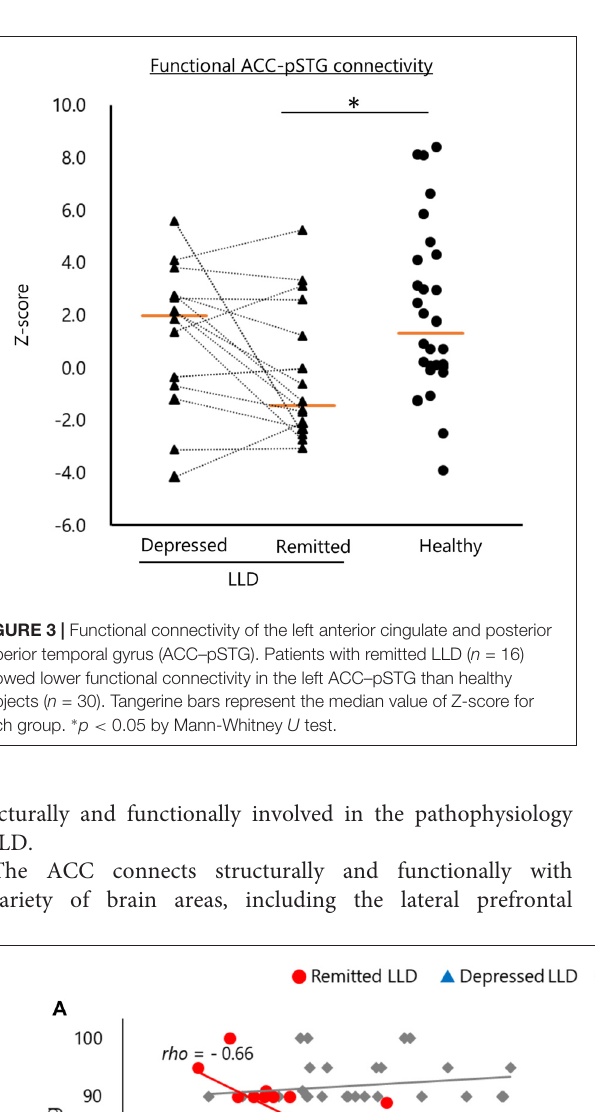
Frontiers in Aging Neuroscience |